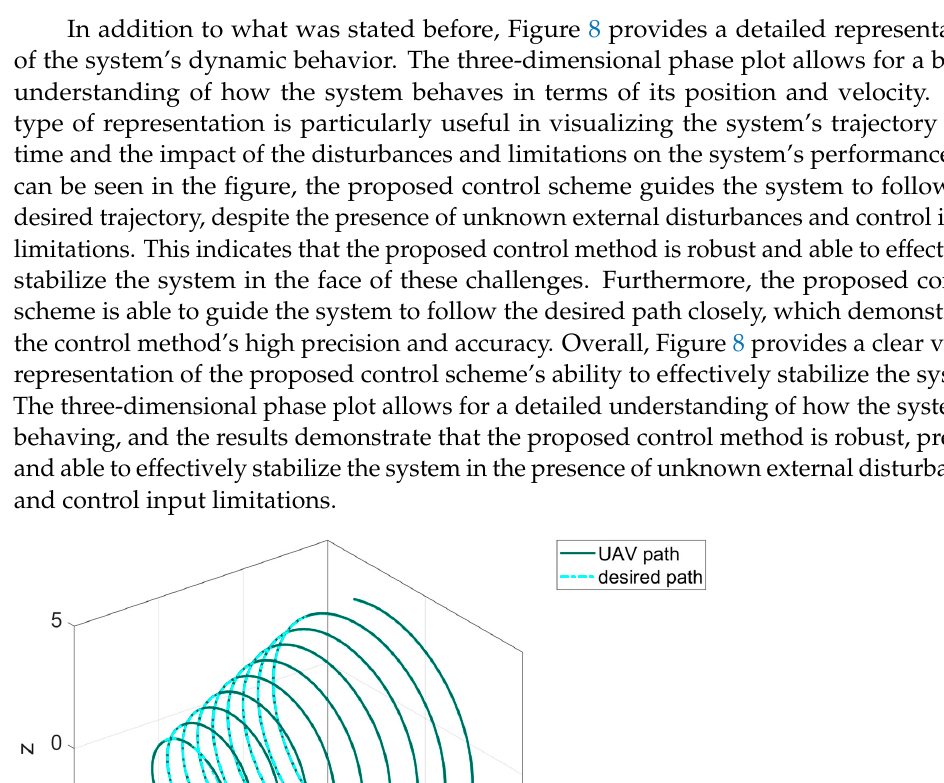
Figure 8. Three-dimensional phase plot illustrating the trajectory of the system under the proposed control